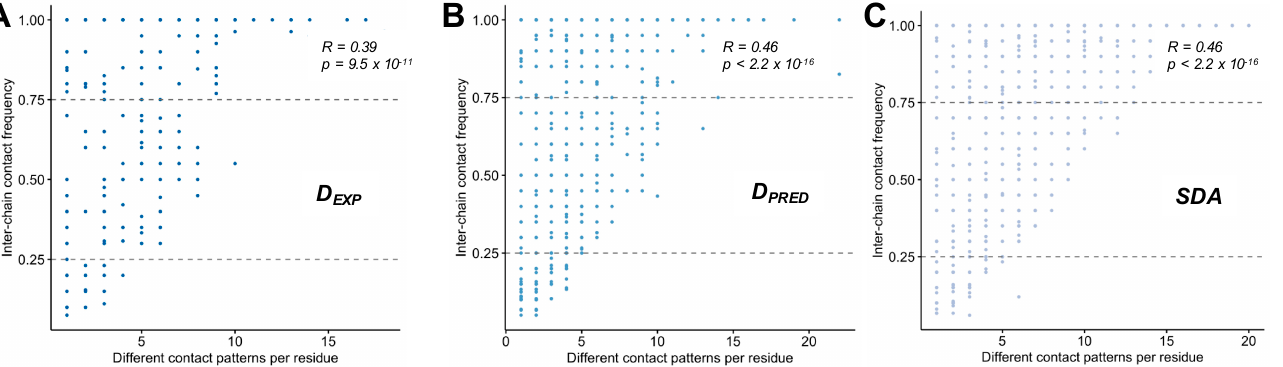
Figure 5. Relationship between contact persistence and variability in ( A ) experimental droplet- driving proteins (D EXP ), ( B ) predicted droplet-driving proteins (D PRED ) and ( C ) specific disordered assemblies (SDA). The extent of contact-pattern variation (shown on the x -axis) does not correlate with the frequency of inter-chain contacts ( y -axis). Contact-pattern variations were defined as shown in Figure 4, and contact frequency was computed as f C = N C /N TOTAL , where N C is the number of models when the residue is in contact, and N TOTAL is the number of all models.